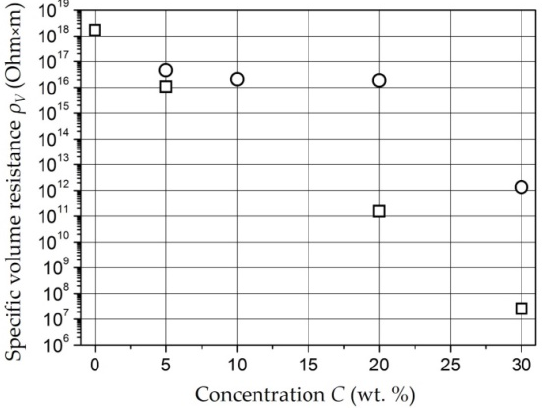
Figure 7. Dependence of resistivity on concentration of NiFe 2 O 4 nanoparticles for tablets 0.25 mm